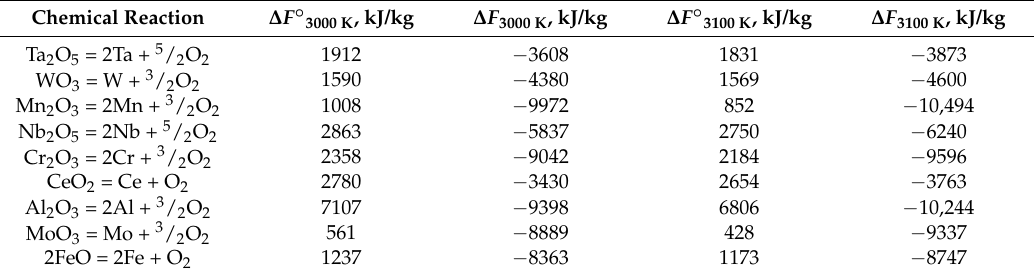
Table 3. Free energy for oxides of Ta and metal inclusions at atmospheric pressure ( ∆ F ◦ ) and at vacuum pressure 10 − 3 Pa ( ∆ F ).